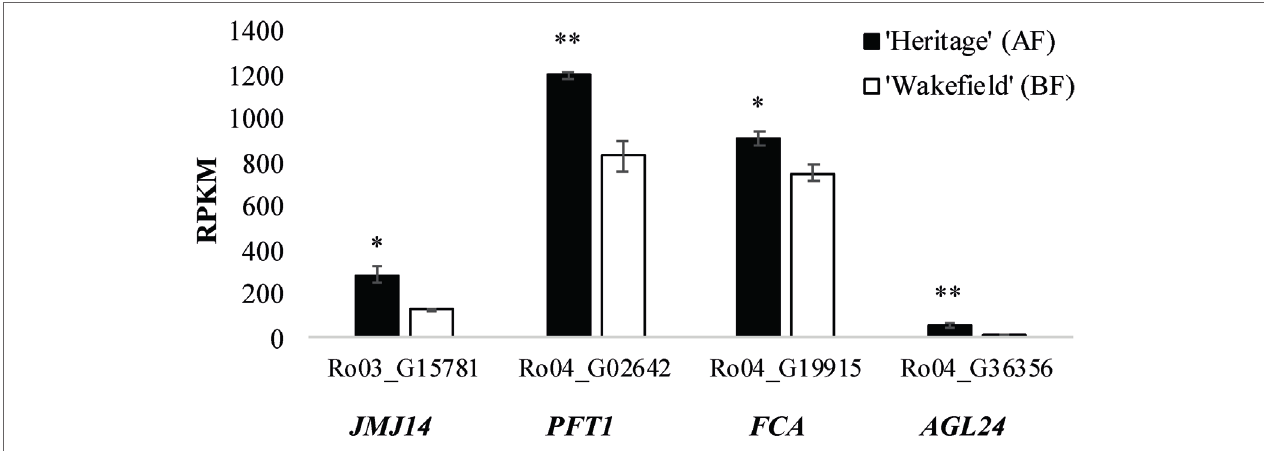
FIGURE 7 | Expression of flowering time genes located in RiAF3 and RiAF4 mapping intervals. RNA was collected from axillary buds in late spring from ‘Heritage’ (Annual-Fruiting, AF) and ‘Wakefield’ (Biennial-Flowering, BF). The x-axis shows RPKM (Reads Per Kilobase Million) for Ro03_G15781 (orthologous to JUMONJI 14 , JMJ14 ), Ro04_G02642 (orthologous to PHYTOCHROME AND FLOWERING TIME 1 , PFT1 ), Ro04_G19915 (orthologous to FLOWERING CONTROL LOCUS A , FCA ), and Ro04_G36356 (orthologous to AGAMOUS-LIKE 24 , AGL24 ). The columns represent the means of three biological replicates, and error bars are standard error of the mean. * and **indicate statistically significant differences ( P < 0.05 and P < 0.01 , respectively) between AF and BF using Student’s t